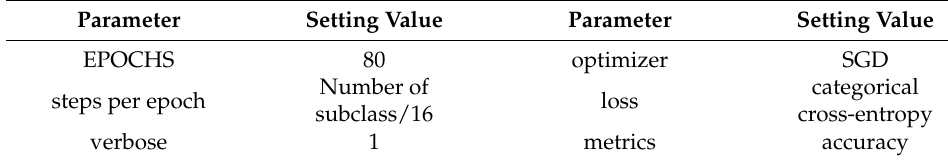
Figure 7. The structure of the CNN model. Table 2. Parameter settings for the CNN model.